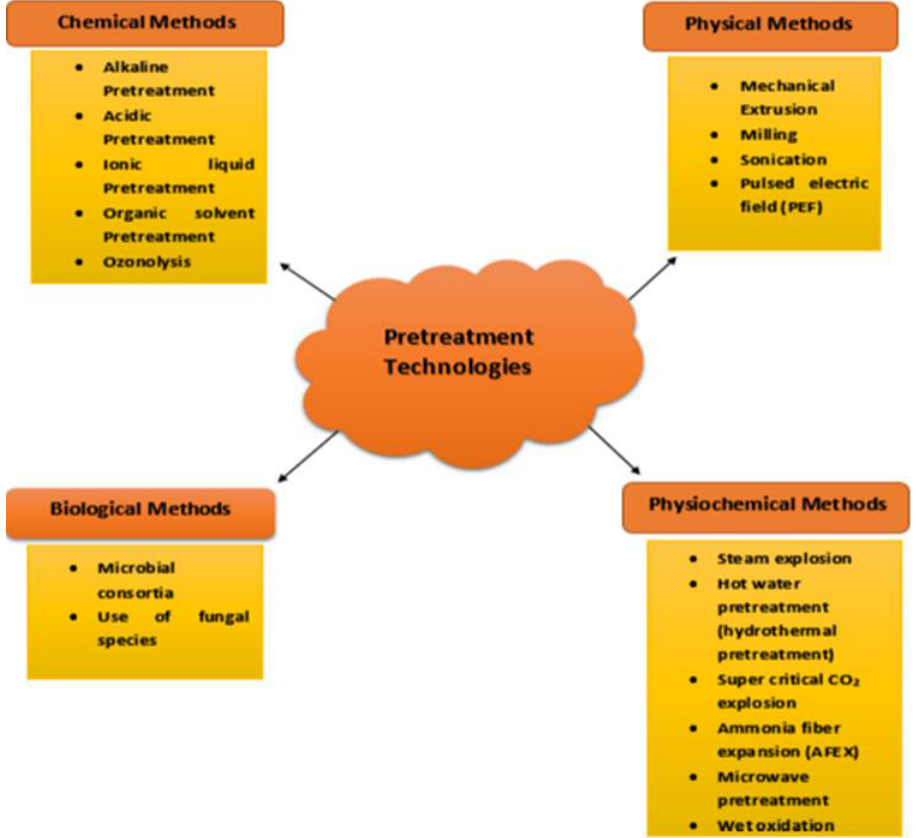
Figure 4. Flowchart of different pretreatment technologies.